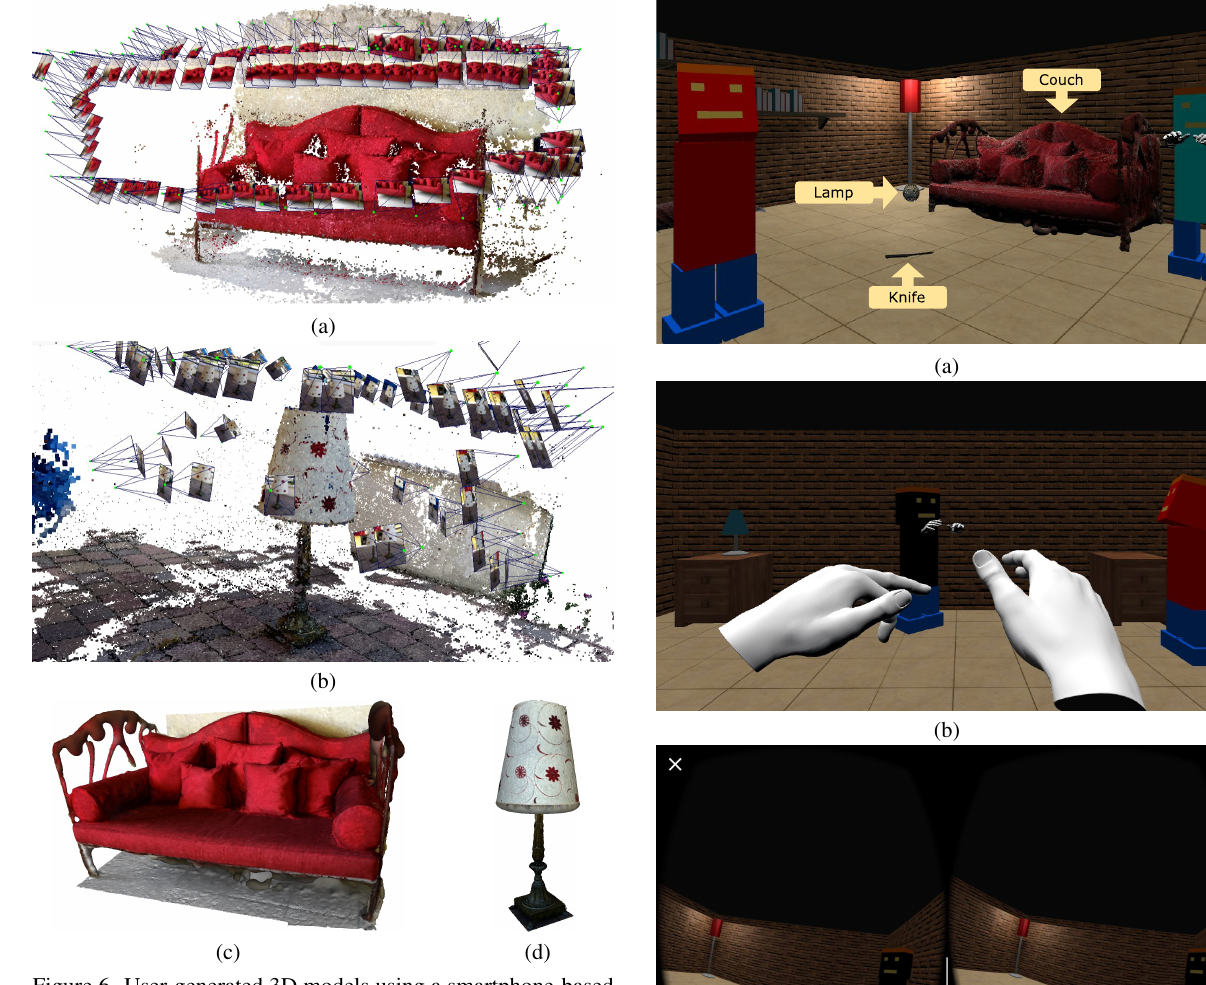
Figure 6. User-generated 3D models using a smartphone-based reconstruction pipeline. Dense point clouds of (a) a couch and (b) a lamp. Oriented images used for the reconstruction can be observed around the dense point clouds. (c,d) 3D models after meshing operation.